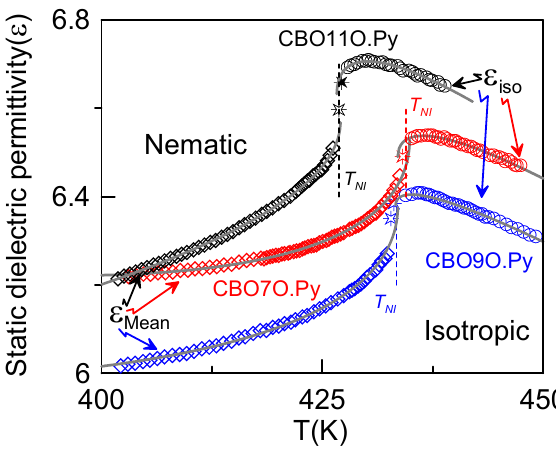
Figure 4. Behavior of the mean static dielectric permittivity (diamonds) in the nematic phase and the static dielectric permittivity (circles) in the isotropic phase for the three liquid crystal dimers. Gray solid lines are fittings according to equations (4a) and